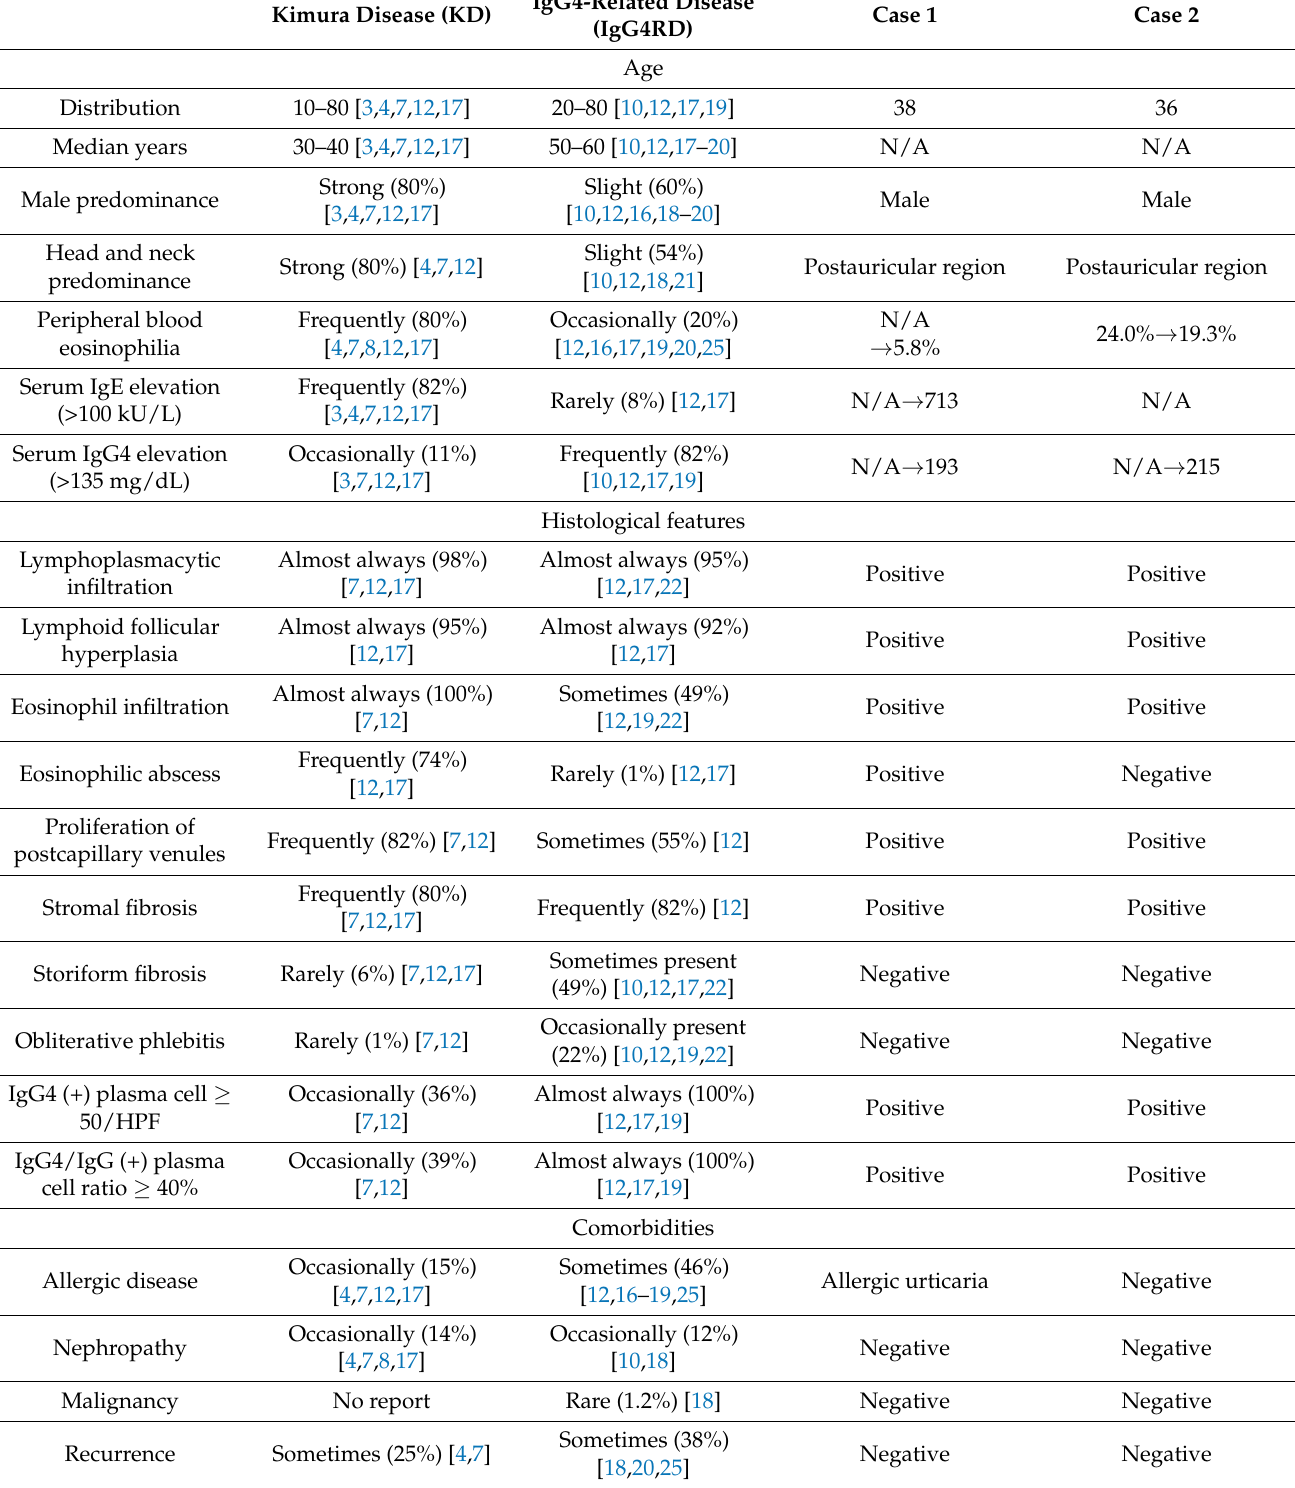
Table 1. Demographic, clinical, histological, and biochemical features in Kimura disease, IgG4-related disease, and the two cases with overlapping